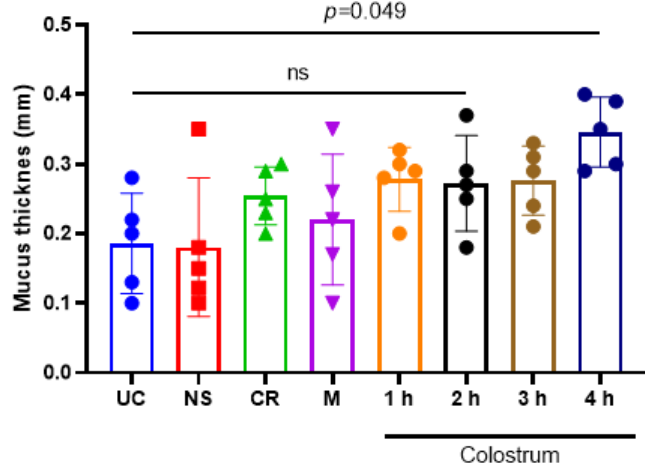
Figure 9. The bovine colostrum feeding resulted in a higher production of mucus in the Wistar rat intestine. The animals received experimental feeding with normal saline (NS), commercial colostrum replacer (CR), milk (M) and the diet-induced changes were compared with colostrum-treated animals or untreated control (UC). The thickness of intestinal mucus was determined after Alcian staining and ImageJ quantification. The results are shown as mean ± SEM from five experimental animals.